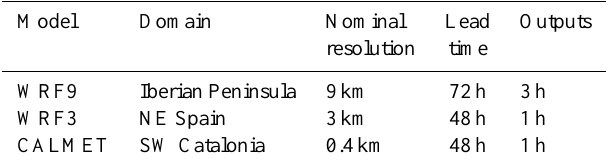
Table 1. Summary of the main characteristics of the three different model configurations used in this study.